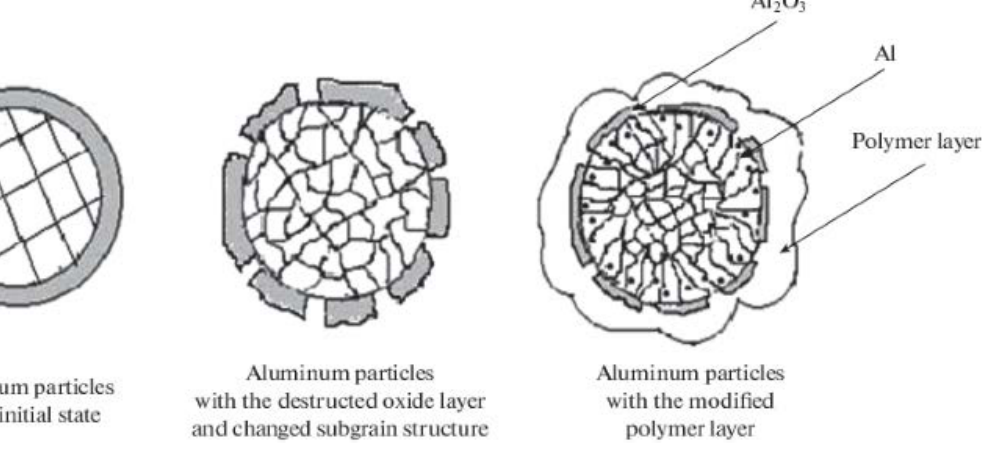
Figure 3. Model of the transformation of the surface layer and the subgrain structure of aluminum particles during MCT [34].